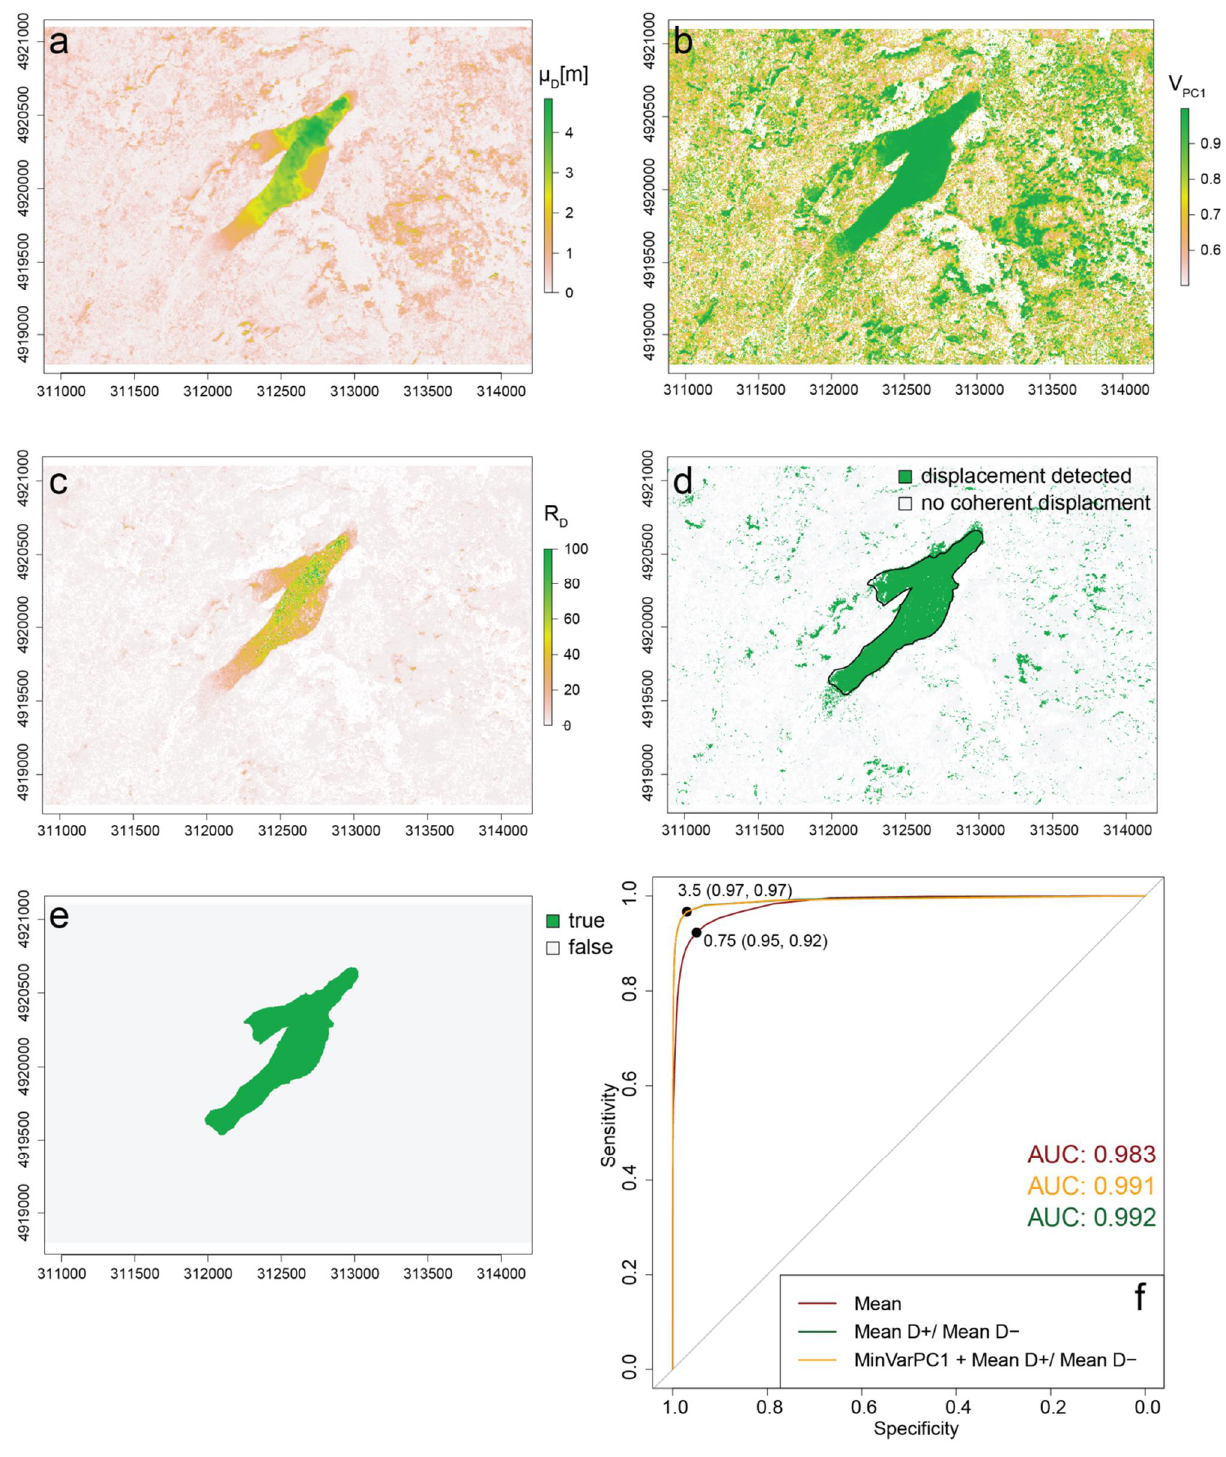
Figure 3. Results of the accuracy assessment for at the La Valette landslide. (a) Mean displacement magnitude over the entire stack, , (c) ratio (cid:1) , (d) the final result after thresholding (cid:1) (b) V (cid:1)(cid:1)(cid:1) (cid:1) (e) the corresponding ground